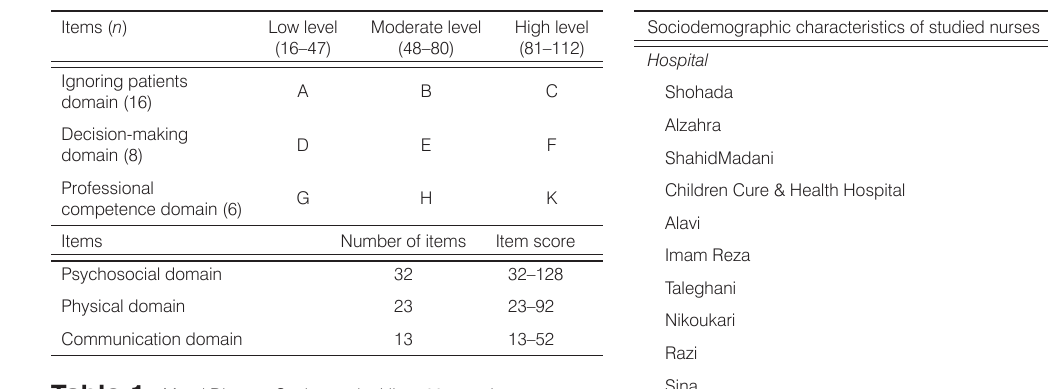
Table 1. Moral Distress Scale 7-point Likert 30 questions